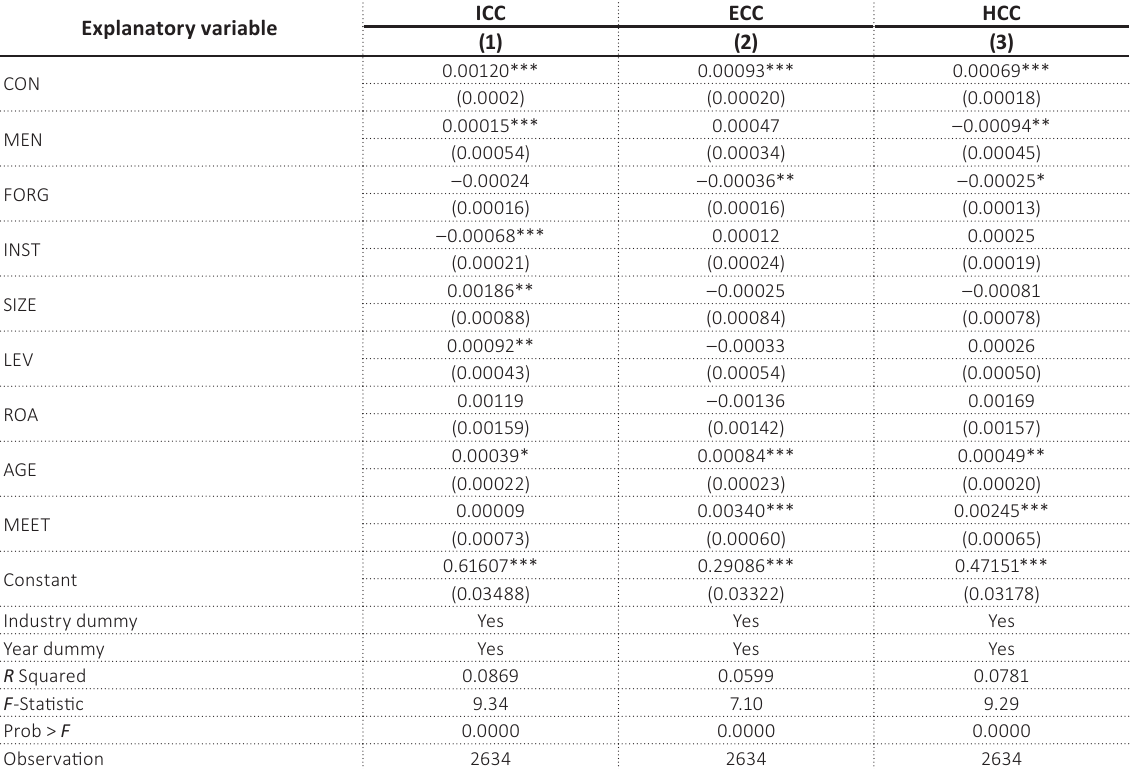
Table 7. Impact of ownership structure on different categories of intellectual capital disclosure Explanatory